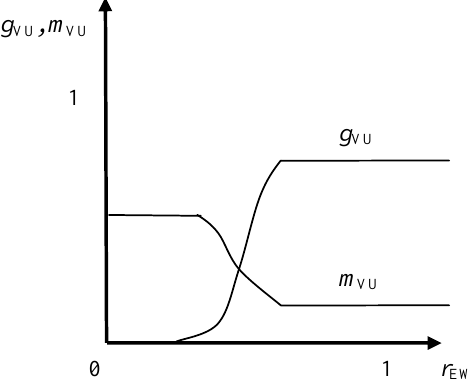
Figure 3. Dependent relationships of the colonization and mortality of natural vegetation depending on the environmental water